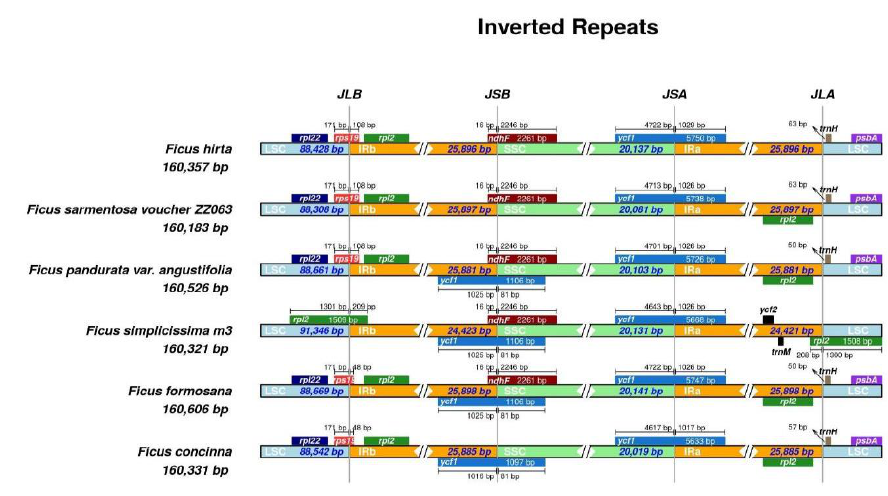
Figure 5. Contiguous positions between LSC, SSC, and IR regions of six Ficus cp genomes.